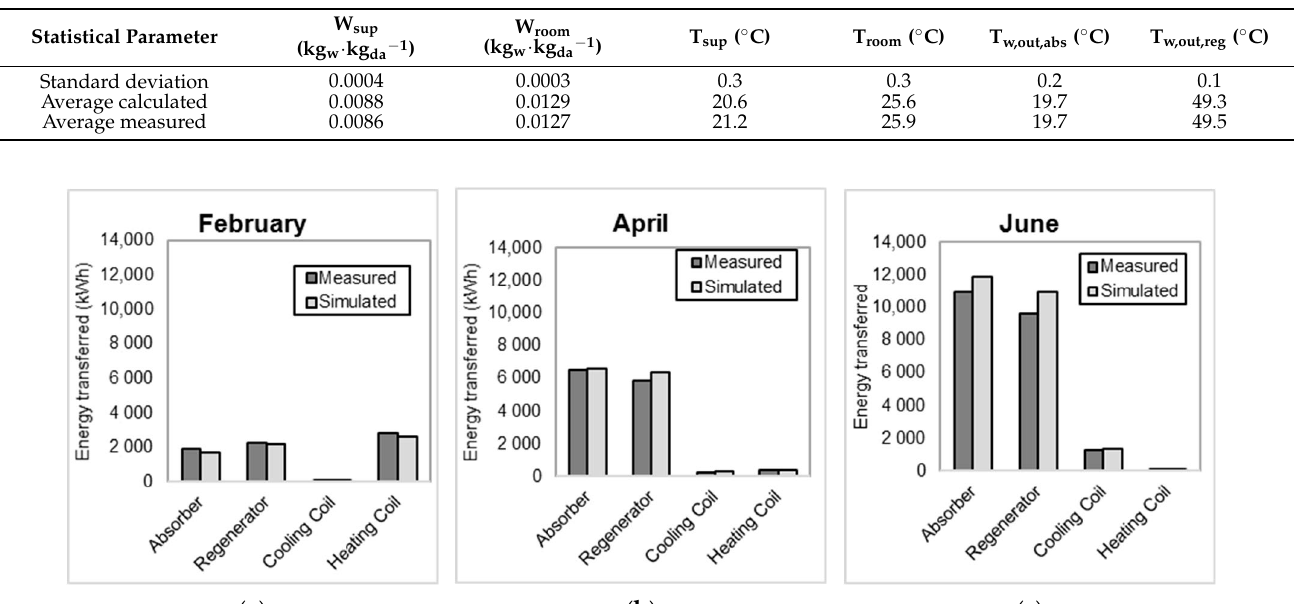
Figure 6. Comparison between the calculated and measured air humidity ratios ( a ) and between the calculated and measured absorber water temperatures ( b ) for a typical day.